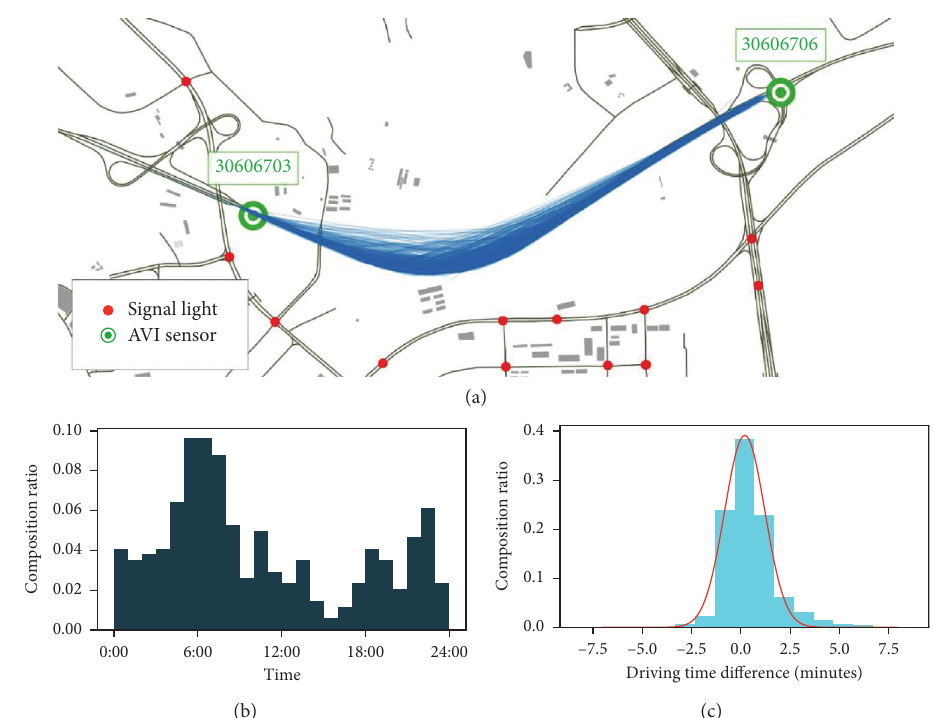
Figure 4: (a) GPS trajectories of samples. (b) Temporal distribution of the samples. (c) Histogram of the temporal constraint between 6:00 and 7:00 (fitting result: μ � 0 . 20 and σ � 1 . 02, goodness of fit: